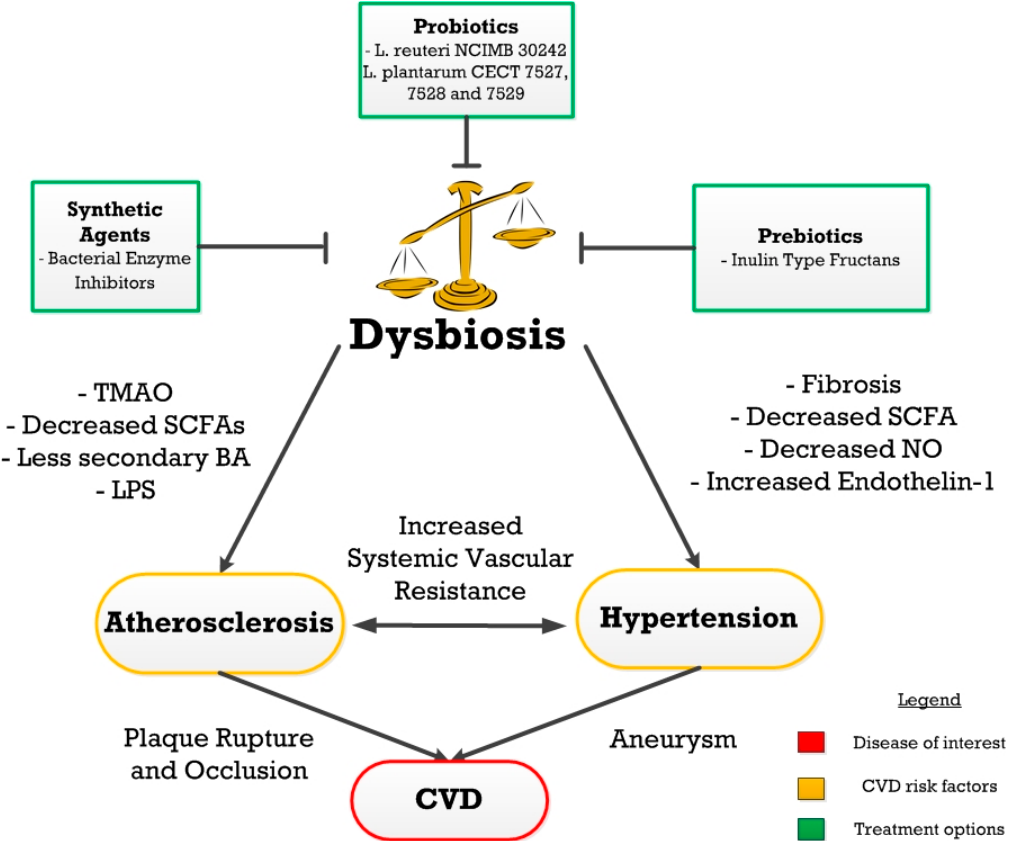
Figure 5. An overview of the relationships between dysbiosis, cardiovascular disease (CVD) risk factors, CVD, and potential treatments. Probiotics, prebiotics and synthetic agents can be used as a treatment for gut dysbiosis which can further prevent the progression of CVDs.